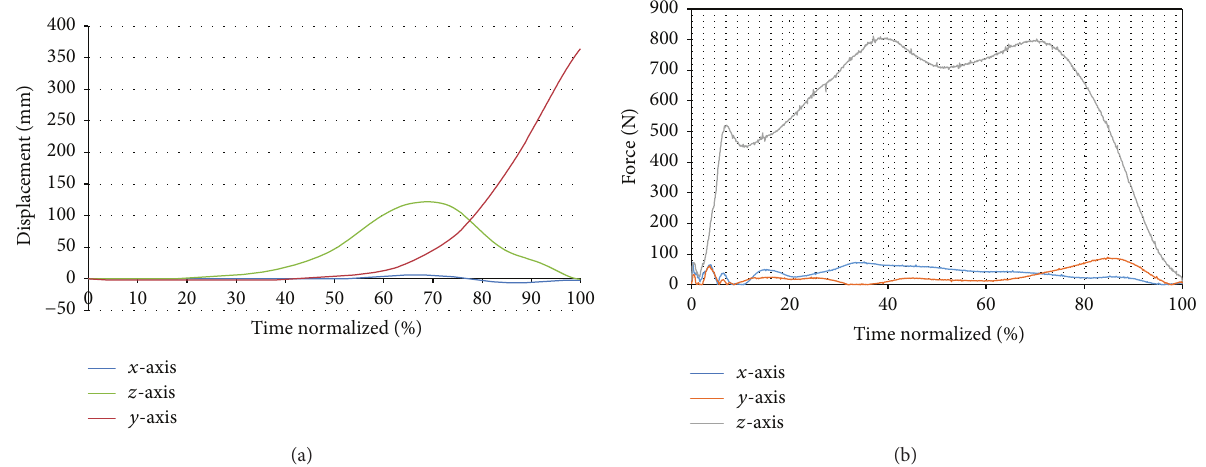
Figure 4: Gait results for paralysed participant (a). (a) Foot trajectory in 𝑥 -, 𝑦 -, and 𝑧 -axes and (b) ground reaction force in 𝑥 -, 𝑦 - and 𝑧 -axes. Kistler force plate (right